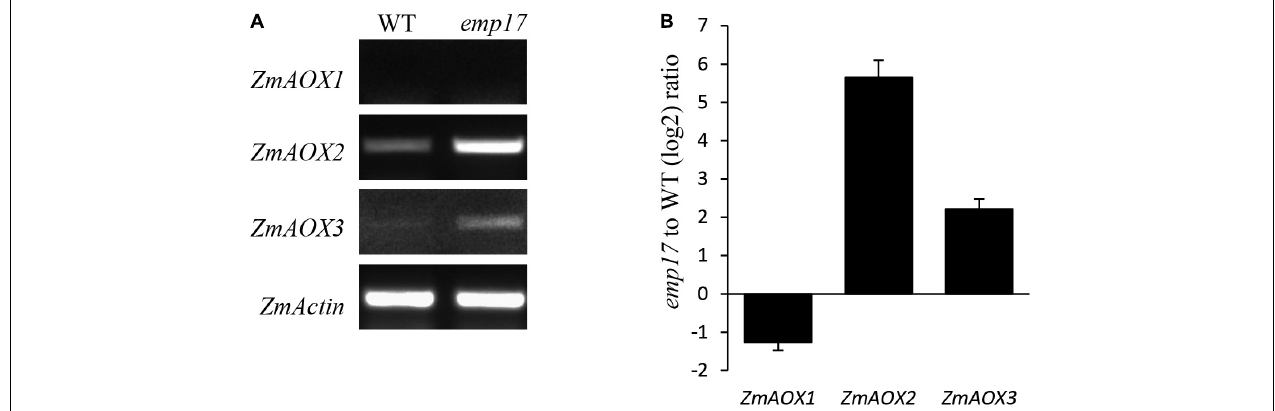
FIGURE 7 | The expression analysis of the ZmAOX genes in wild type and emp17 . (A,B) RT-PCR and qRT-PCR were used for analyzing the expression of the ZmAOX genes in wild type and emp17 , respectively. RNA was extracted from 14 DAP embryos and endosperms. qRT-PCR values represent three biological replicates and are normalized against ZmActin . Error bars represent the ± SD.